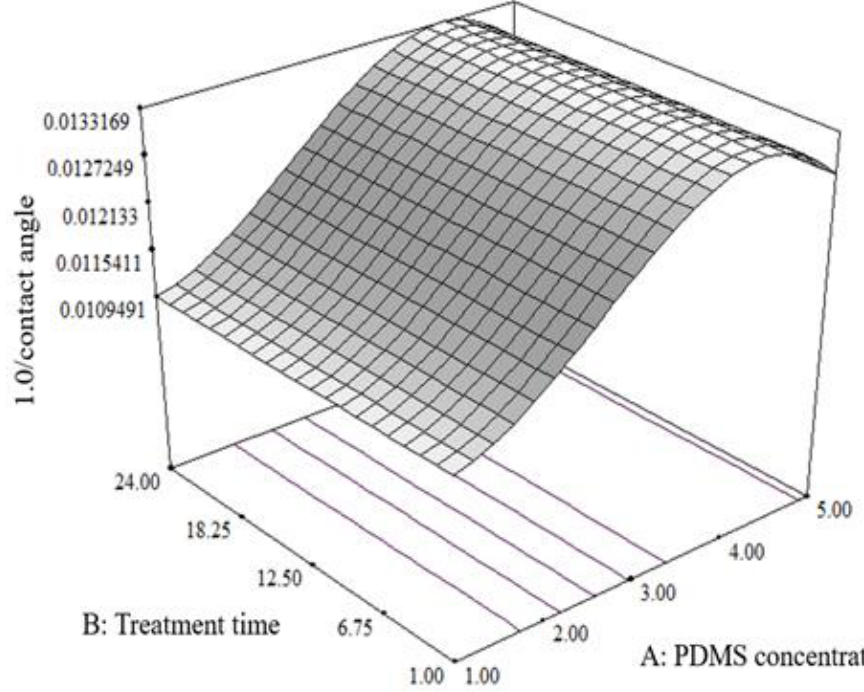
Figure 3. Response surface plot of PDMS concentration versus treatment time on the contact angle value of the borosilicate glass.